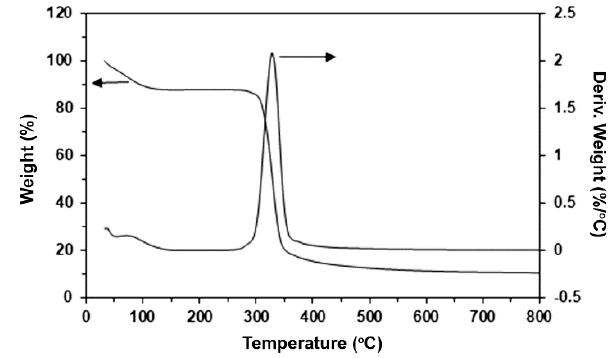
Figure 3. TG thermograms of ( above ) PLLA/starch and ( below ) PLLA-PEG-PLLA/starch compo- sites with various blend ratios.